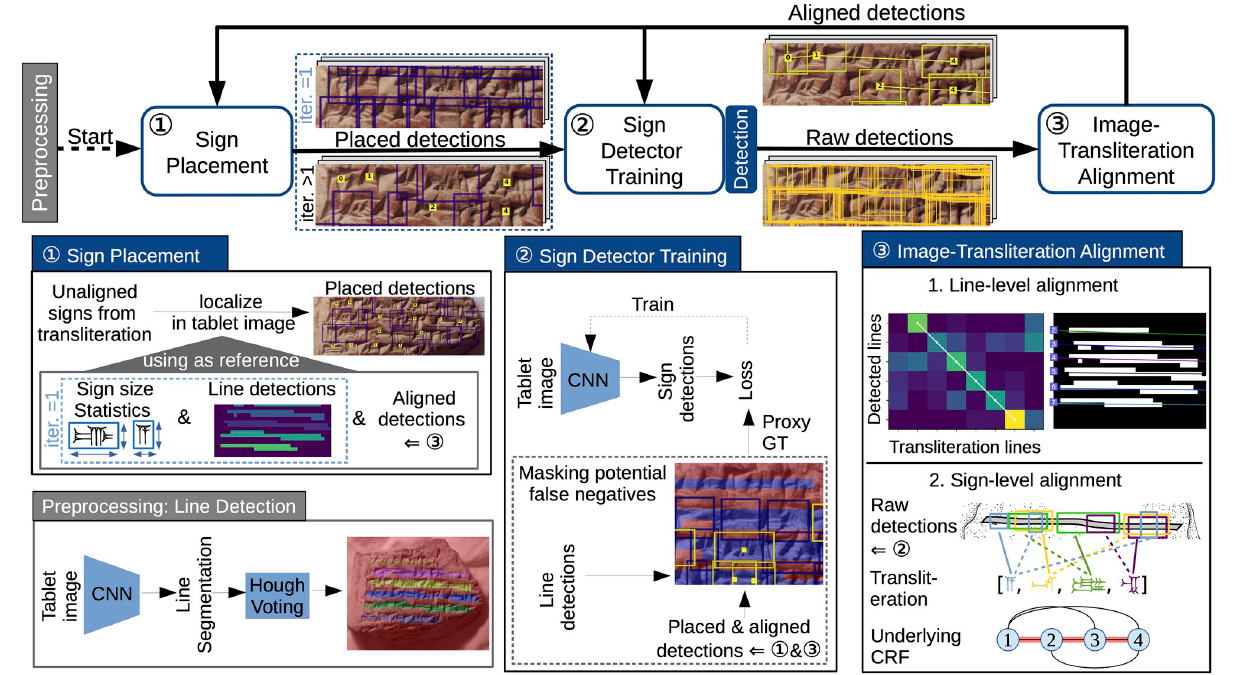
Fig 3. Weakly supervised training of sign detector comprises an iterative training loop with three steps. In each iteration the sign placement method localizes transliterated signs in the tablet image using detected lines and aligned detections as reference points. In the second step, the aligned & placed detections serve as sign annotations for training a sign detector. In the third step, the image-transliteration alignment filters the raw sign detections produced by the sign detector after the second step. Only the raw detections that are consistent with the transliteration and the line geometry are selected. The resulting aligned detections are very reliable sign annotations, which boost sign detector training in the next iteration. As pre- processing, we detect lines in all tablet images to simplify localization and alignment. Image material by the authors.